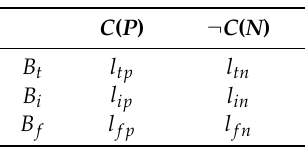
Table 1. The loss expectation